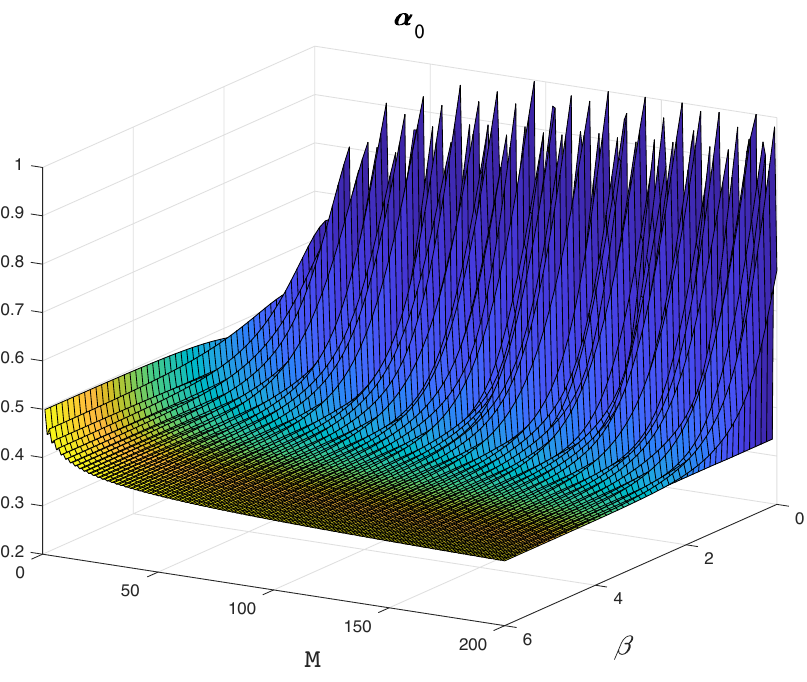
Figure 3 . The \critical landscape": (cid:11) 0 values above the surface give positive residues (here and in the following (cid:13) = (cid:12) +